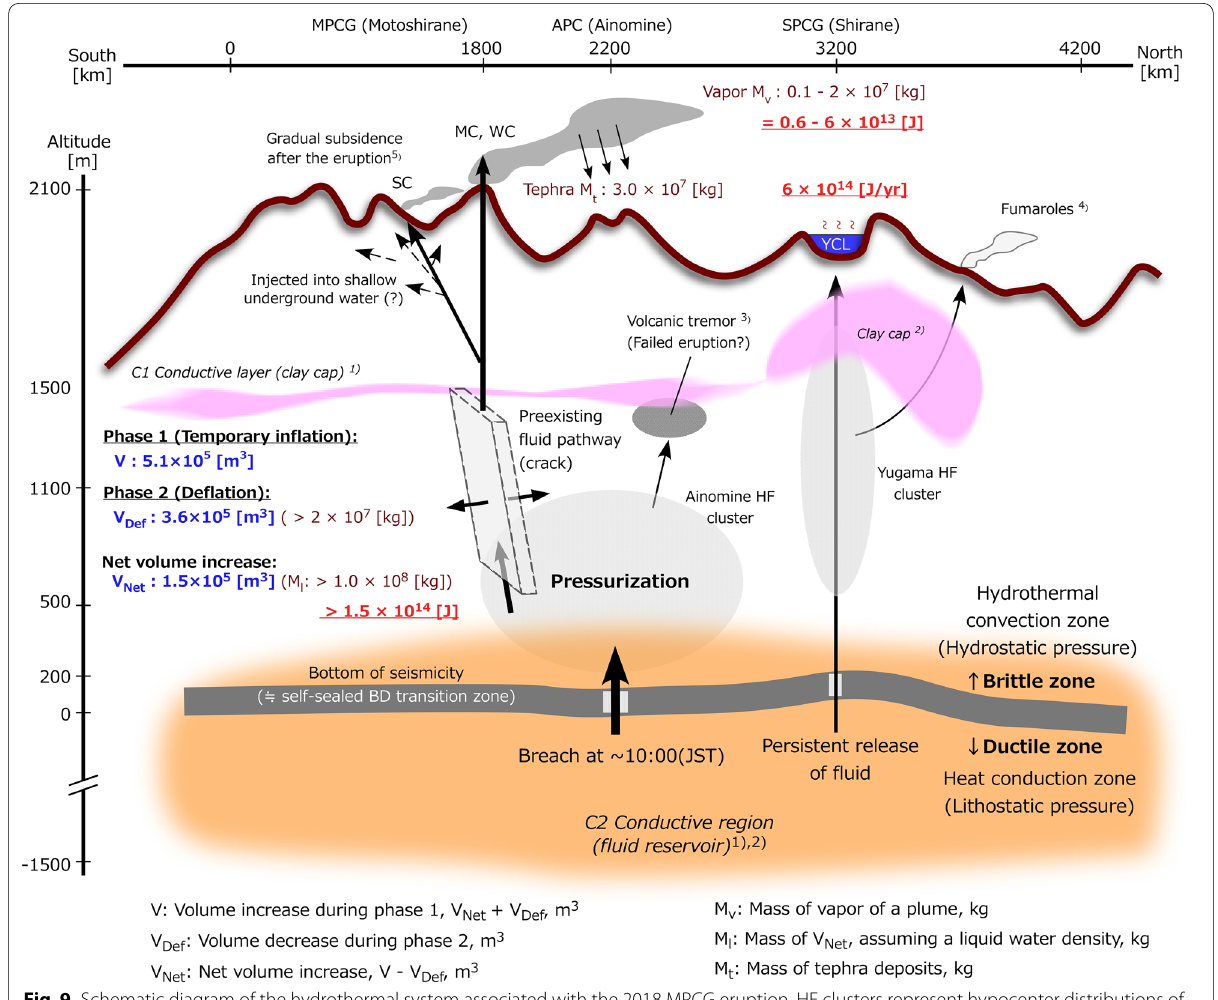
Fig. 9 Schematic diagram of the hydrothermal system associated with the 2018 MPCG eruption. HF clusters represent hypocenter distributions of high frequency volcanic–tectonic earthquakes. The depth of the self-sealed brittle–ductile transition zone is based on the hypocenter distribution (Figs. 5–7). 1 Matsunaga et al. (2020); 2 Tseng et al. (2020); 3 Yamada et al. (2021); 4 Ohba et al. (2019a, b); 5 Himematsu et al.